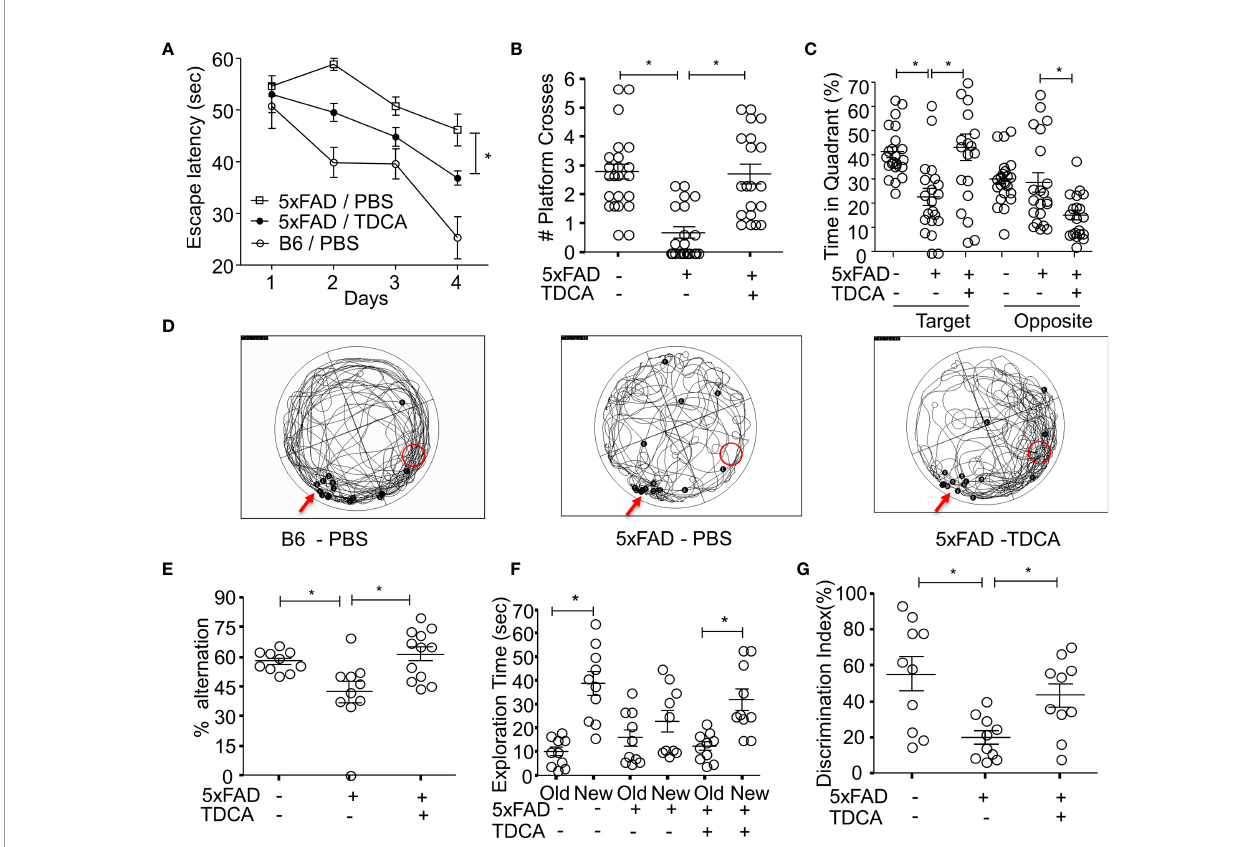
FIGURE 6 | TDCA improves spatial learning and memory of the 5xFAD mouse. The learning and memory of 5xFAD and B6 (5xFAD - ) mice were tested after treatment with TDCA 1 mg/kg i.p. for 10 weeks (n = 20~22/group). The time to reach the hidden platform (escape latency) (A) and the number of platform crosses (B) were measured using the MWM test. The time spent in the target quadrant where a platform is located, and the opposite quadrant (C) were calculated from the MWM test. (D) , Trajectory maps show the escape route of all mice in the MWM test in a set of experiments. The red arrows and red circles indicate release points and positions of the platform, respectively. Black dots indicate the beginning (B) and end (E) points for individual mice. (E) , Alternation percentages of mice (n = 9~12) in the Y-maze test were calculated by 100 × # spontaneous alternation/# of total arm entry. (F) , Total exploration time for each object of individual mice in the NOR test is depicted. (G) , Discrimination index (%) = 100 × time spent exploring the novel object/exploration time for both the novel and old objects for each mouse (n = 10). The individual samples are shown with the mean ± SEM and *P <0.05 using Student ’ s unpaired